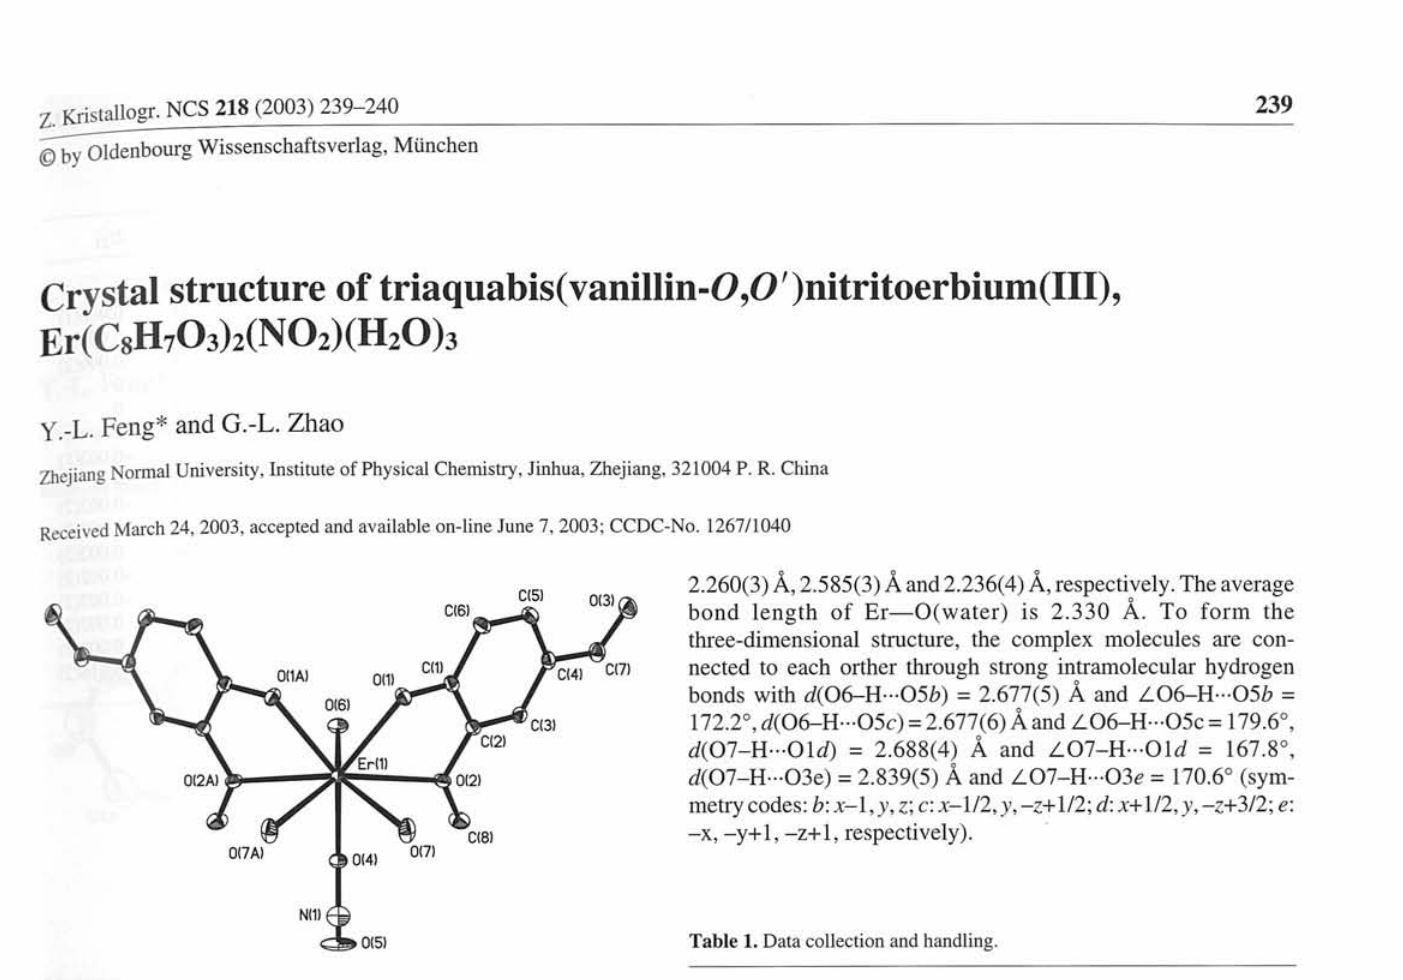
Table 1. Data collection and handling. Crystal: